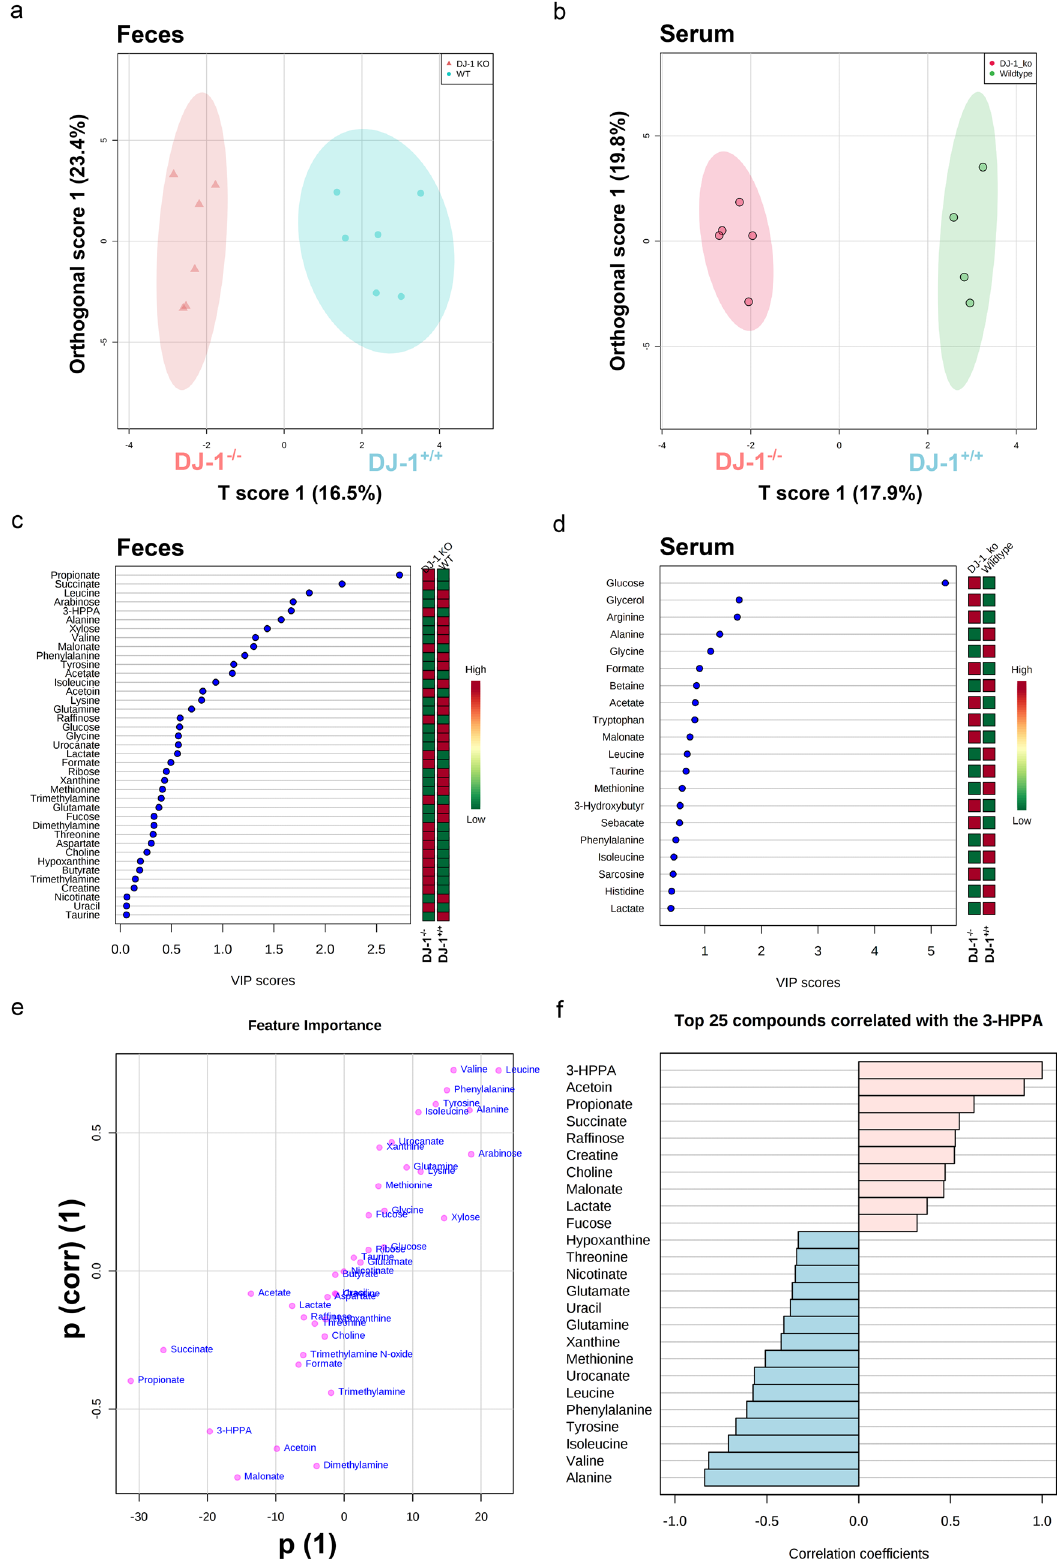
Figure 5. DJ-1 −/− feces metabolites differently clusters and have difference in metabolite production than the DJ-1 +/+ feces. (a, b) Orthogonal partial least squares discriminant analysis (oPLS-DA) with the corresponding s-plot clearly separates DJ-1 +/+ and DJ-1 −/− groups in feces and serum samples. (c, d) Partial least squares discriminant analysis PLS-DA with VIP scores for the top 20 metabolites in feces and serum samples. (e) SCFAs and amino acids being the most discriminating metabolites, indicating a general switch from protein towards fibre degrading strains in DJ-1 −/− feces. (f) The pattern hunter of the newly in feces identified phenolic metabolite 3-(3-Hydroxyphenyl) propanoic